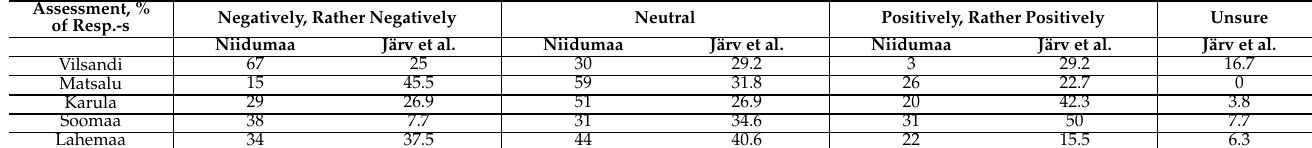
Table 3. National park effect on freedom of action and opportunities, by park (Niidumaa, 2009; Järv et al., 2021). Assessment, % of